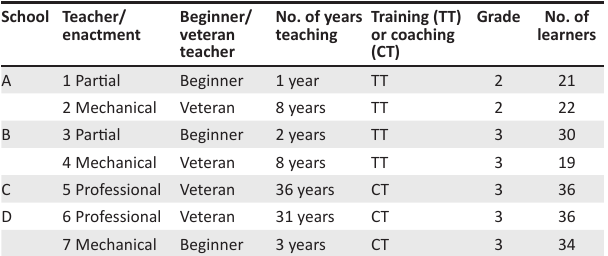
TABLE 2: Summary of the teachers’ enactment. School Teacher/